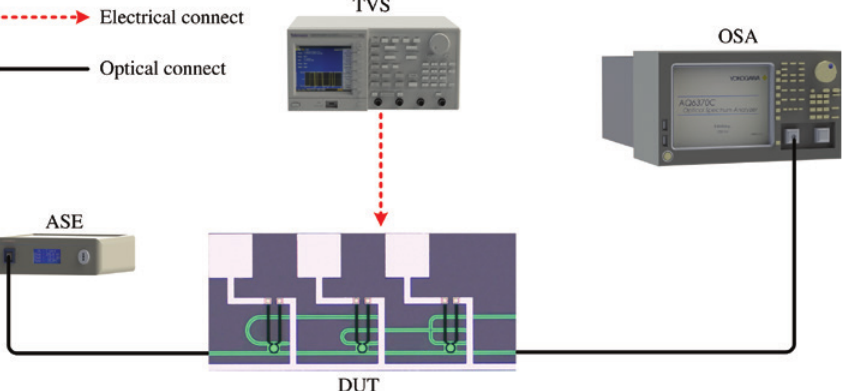
Figure 4: Experiment schematic for the static response of the device (ASE, amplified spontaneous emission source; TVS, tunable voltage source; OSA, optical spectral analyzer; DUT, device under